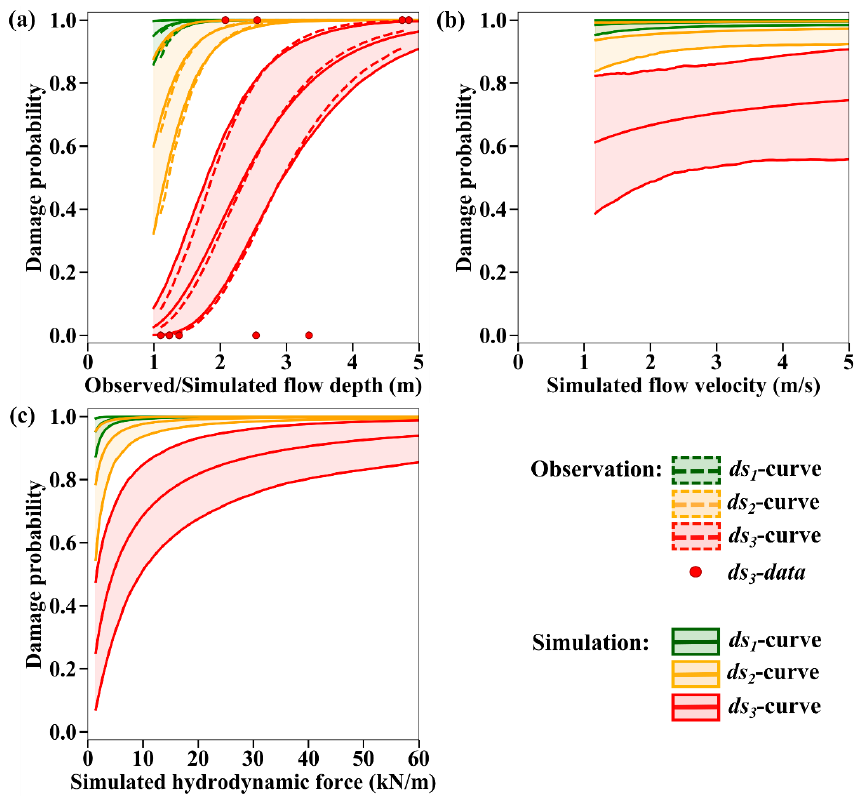
Figure 14. The 2018 Sunda Strait curves for timber buildings. Best-estimate fragility curves, with their 90% confidence intervals, as functions of (a) the observed and the maximum simulated flow depths, (b) the maximum simulated flow velocity, and (c) the simulated hydrodynamic force for timber buildings of DB_Sunda2018 sustaining minor or moderate damage ( ds 1 ), major damage ( ds 2 ), and complete damage or washed away ( ds 3 ) in Sunda Strait